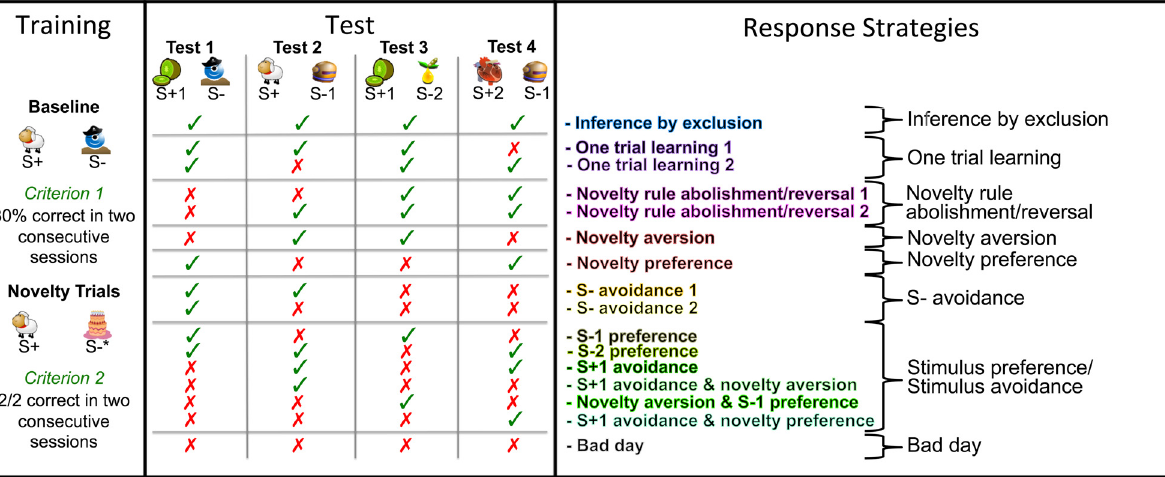
Fig 2. Experimental Overview. Schematic representation of one of each baseline trials, novelty trials and test trials with example stimuli, as well as theoretical response predictions (see main text) colour-coded to match response patterns in Fig 4; + indicates stimuli with positive reward contingency, — indicates unrewarded stimuli; ✓ correct, ✗ incorrect choices. On the right we list the most parsimonious mechanisms (see main text).